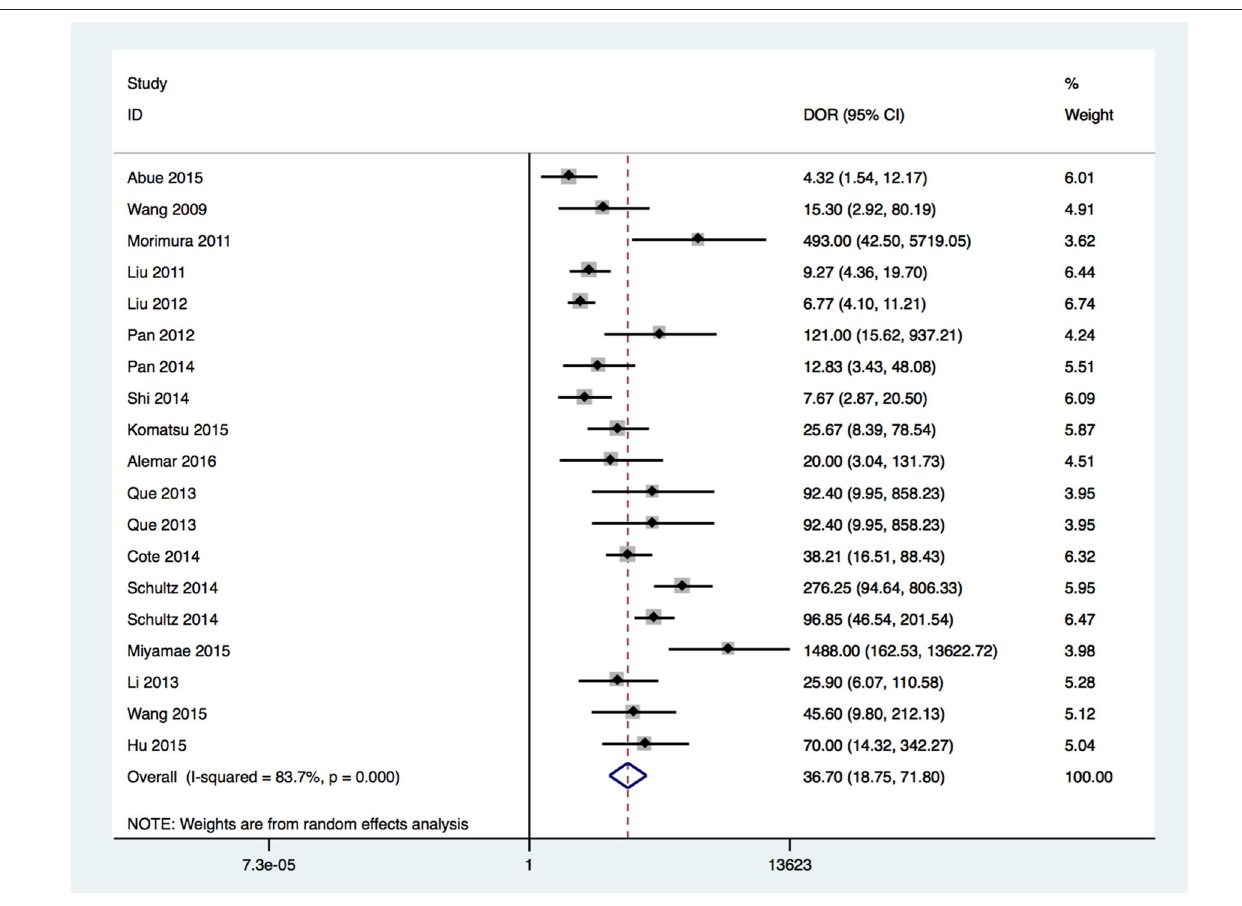
FIGURE 3 | Forrest plot of estimates of